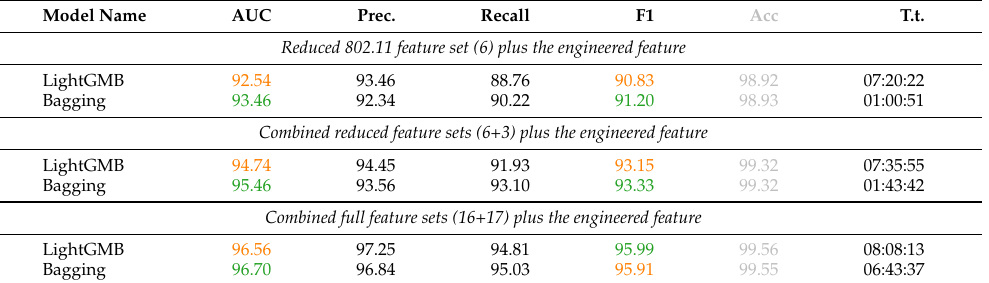
Table 9. Results on feature sets embracing the “Insider” engineered feature. Best and worse AUC and F1 scores are shown in green or orange text,